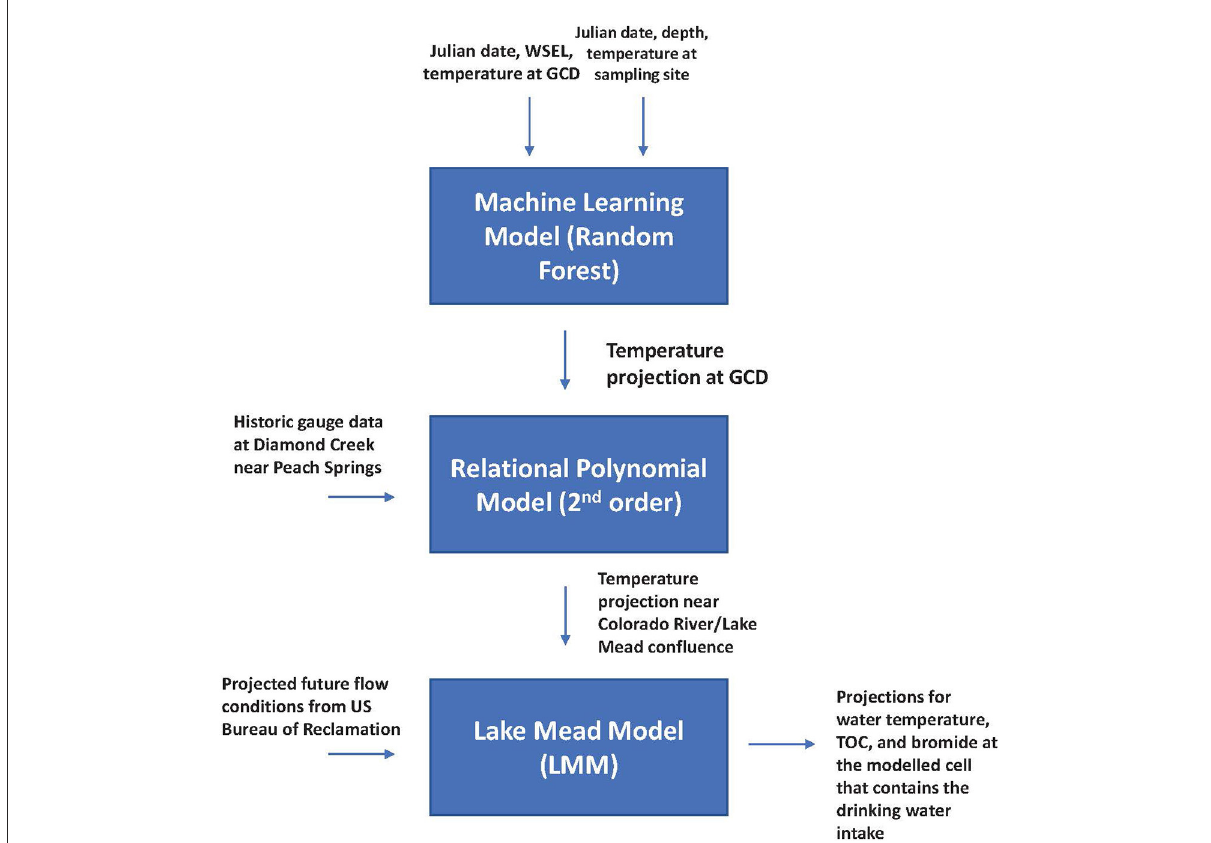
FIGURE4 Three-part modeling